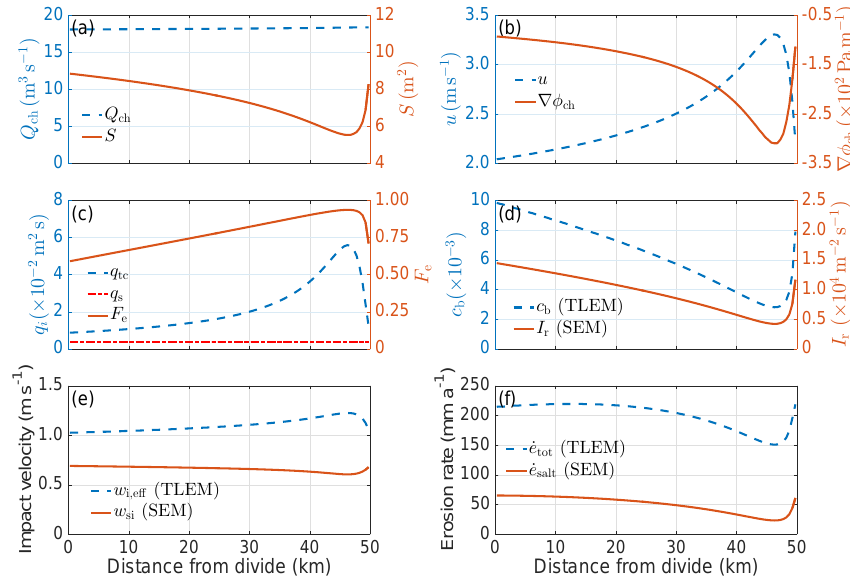
Figure 2. Relationship between the hydraulic and erosion variables in a steady-state R-channel with constant discharge (Table 3, S_MOULIN; Sect. 4.1.1). Components of TLEM and SEM are also compared. (a) R-channel discharge, Q ch , and cross-sectional area S ; (b) velocity, u , and gradient in hydraulic potential, ∇ φ ch ; (c) sediment transport capacity, q tc , prescribed sediment supply rate, q s , and fraction of bed exposed, F e ; (d) near-bed sediment concentration, c b (TLEM), and impact rate, I r (SEM); (e) impact velocity in the TLEM, w i , eff , and the SEM, w si ; and (f) erosion rate calculated with the TLEM, ˙ e tot , and the SEM, ˙ e salt .